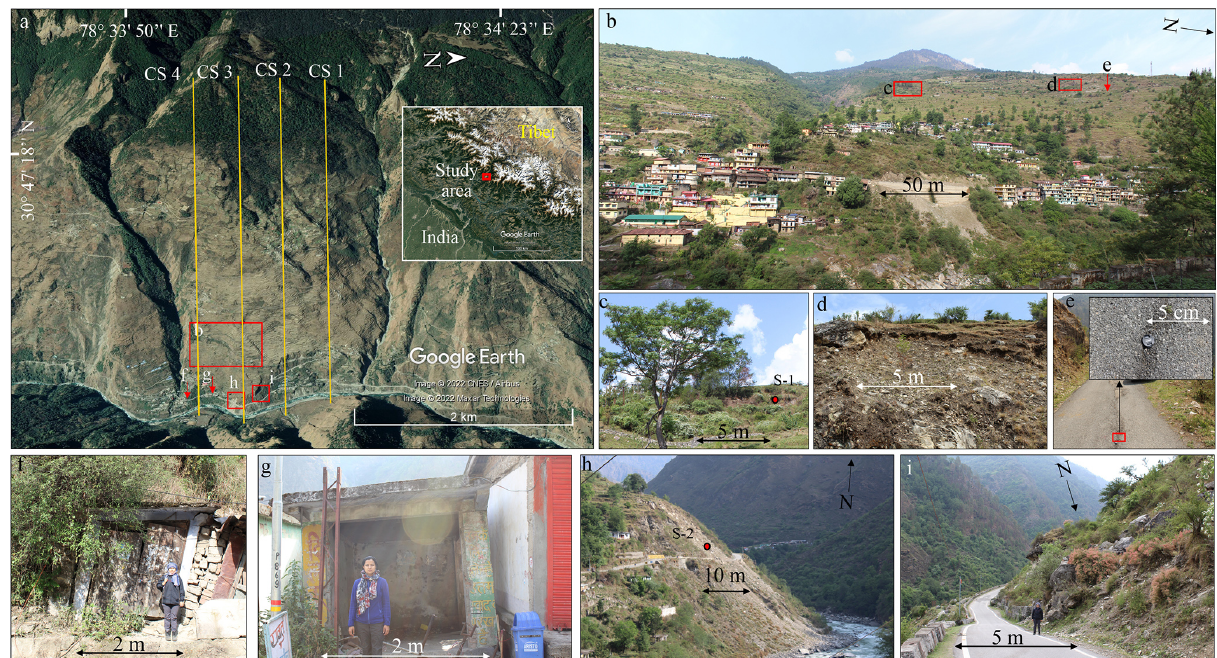
Figure 2. Field observation of Bhatwari. © Google Earth for panel (a) . (a) Location of Bhatwari with the inset highlighting its position in the NW Himalaya. CS 1 to CS 4 mark the position of 2D slope sections used for the slope stability evaluation. (b–d) Exposed scarp. S-1 refers to the soil sampling site, (e) cracks and displacement of the road, (f–g) tilting houses and shops, (h) active slope failure at the slope toe, and (i) big gneissic boulder implying a paleo-landslide